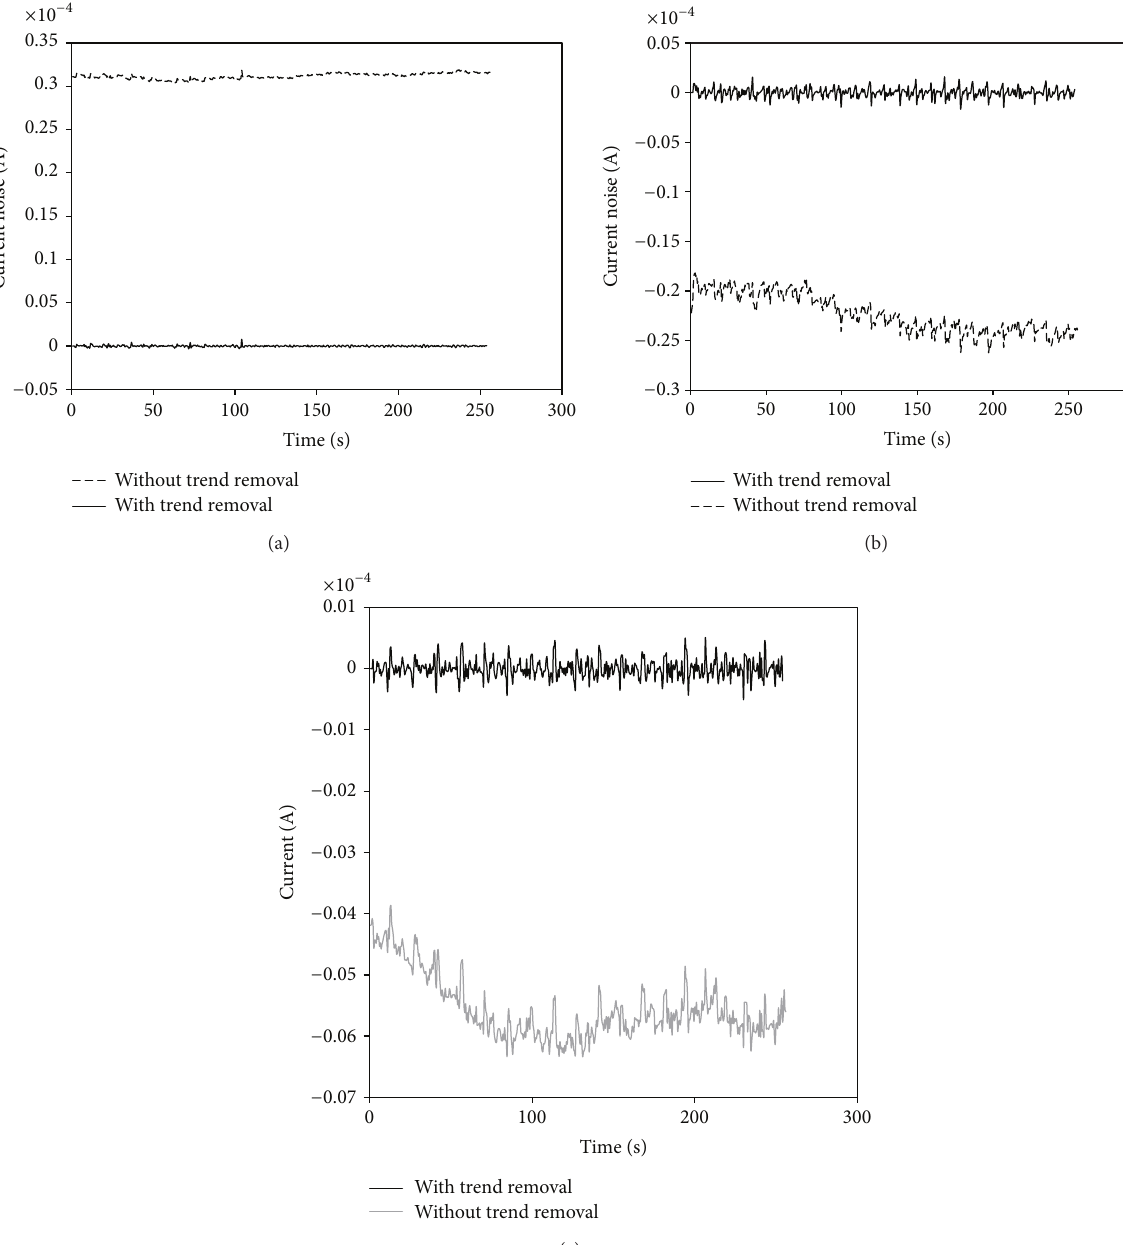
Figure 5: Electrochemical current noise diagrams before and after trend removal for composite coatings obtained from plating bath containing different concentration of nano-Al 2 O 3 particles: (a) blank, (b) 5 ppm, and (c)